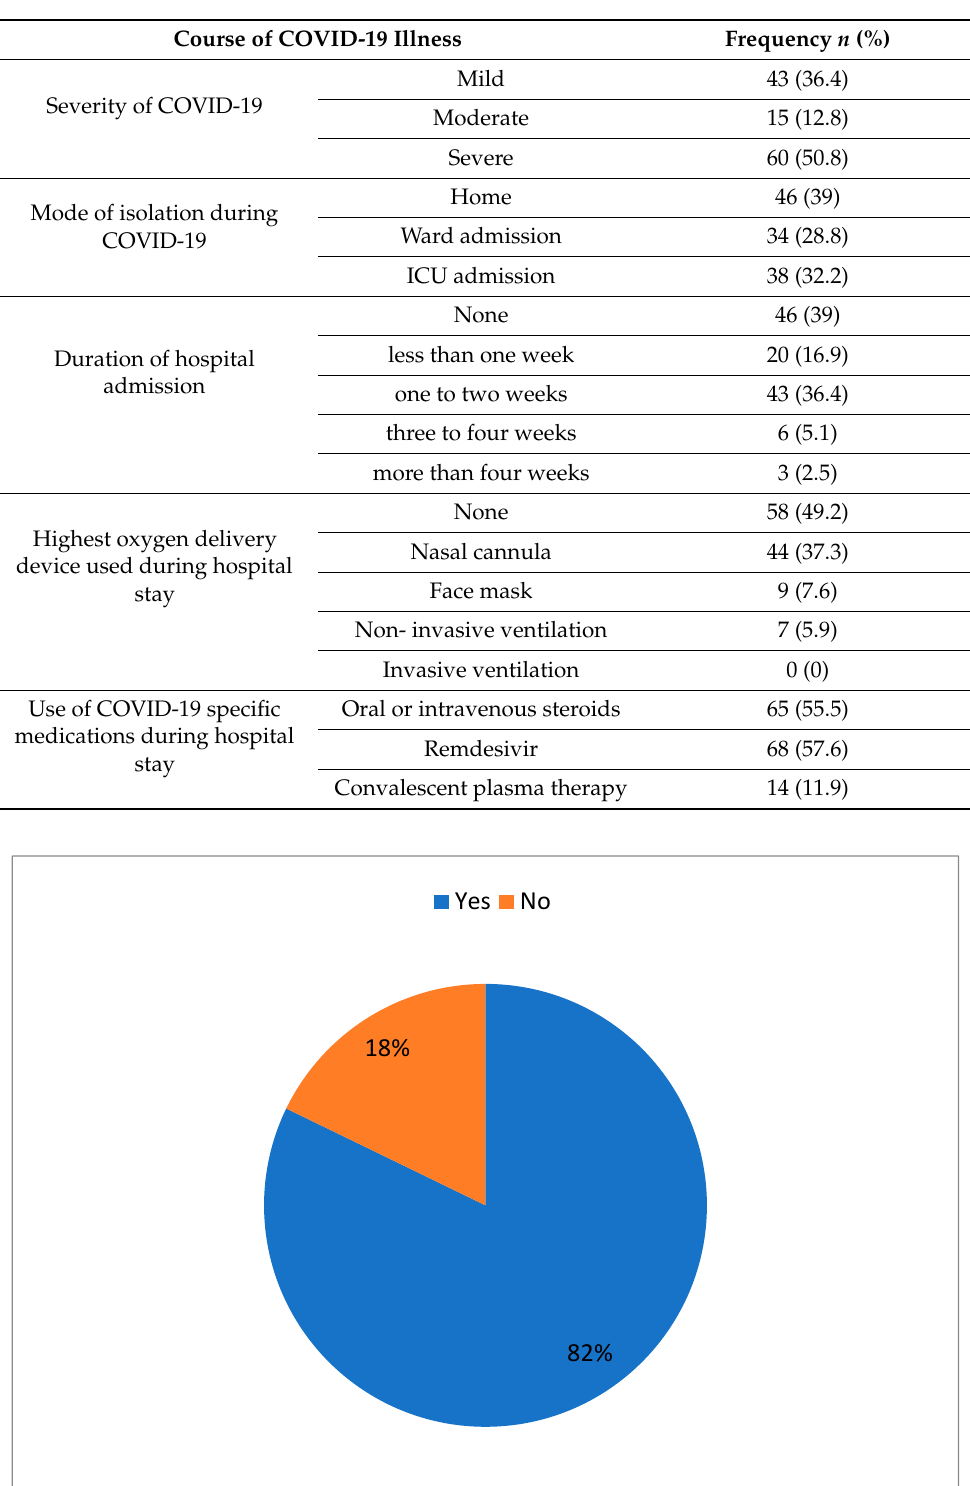
Table 3. Course of COVID-19 illness in post-COVID patients presenting to follow-up OPD at STIDH (N-118).